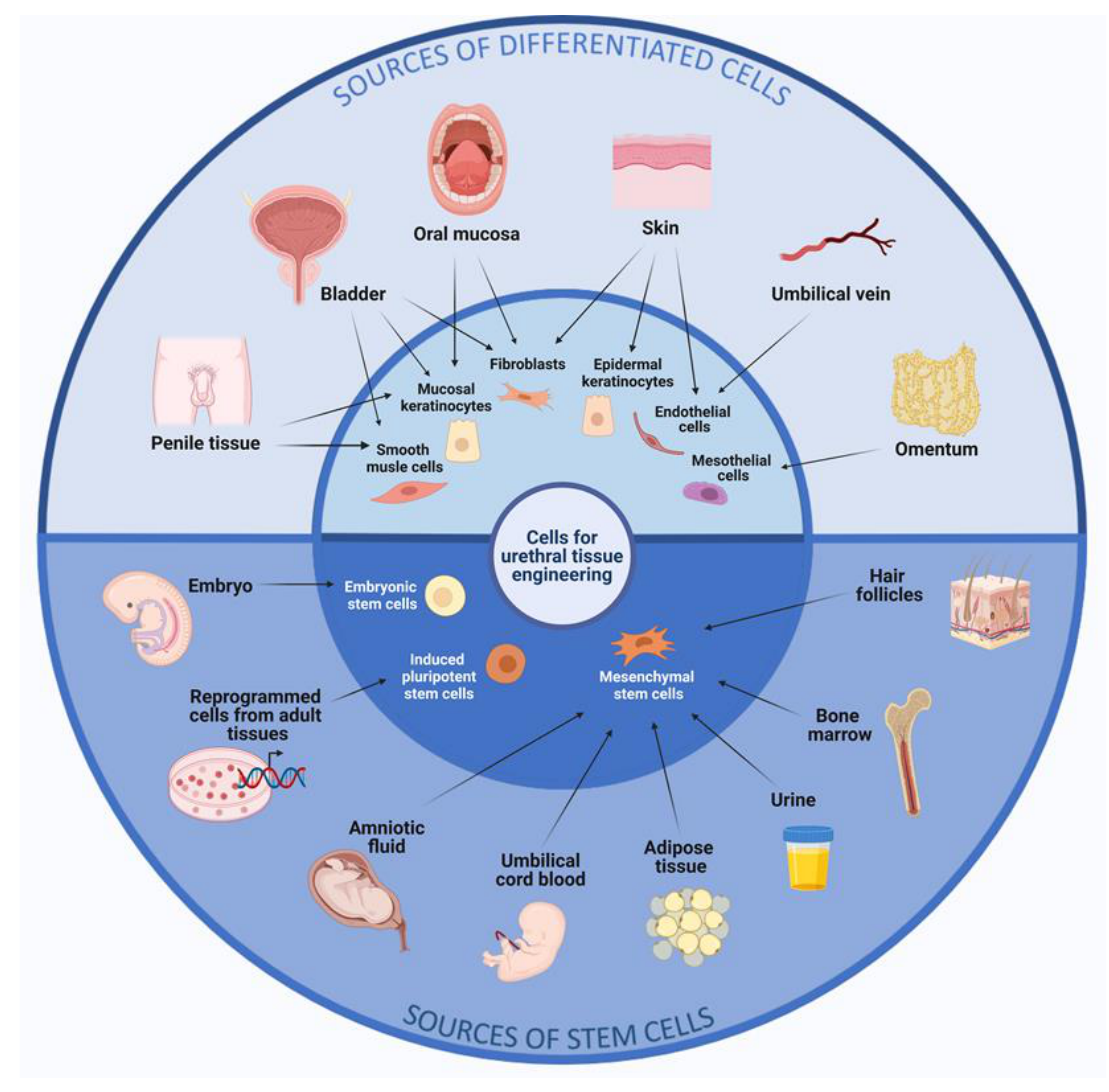
Figure 1. Schematic overview of the different tissue sources for cells relevant to urethral tissue engineering. The sources are divided into two categories: differentiated cells and stem cells.